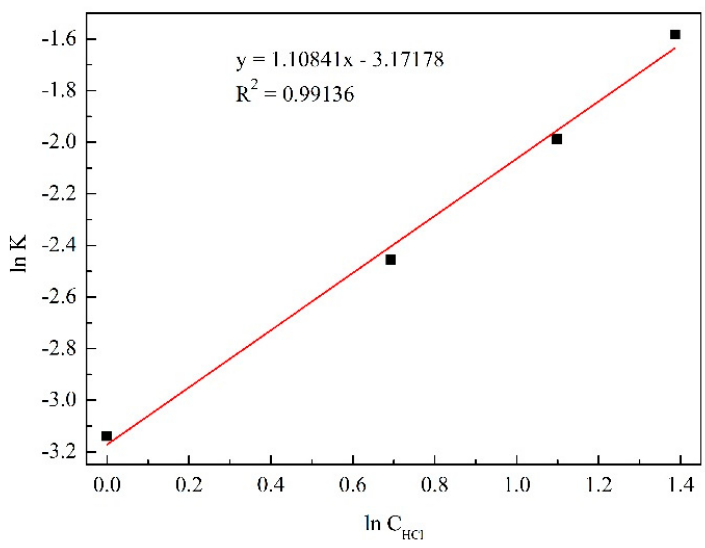
Figure 13. Plot of lnk vs. lnC HCl in alkali fused SCC leaching process. Results shown in Figure 6(right) were substituted into Equation (24), and variations of ln[ − ln(1 − η )] with lnt were plotted as a function of leaching temperature (Figure 14). The linear fitting regression equations and correlation coefficients are listed in Table 4.